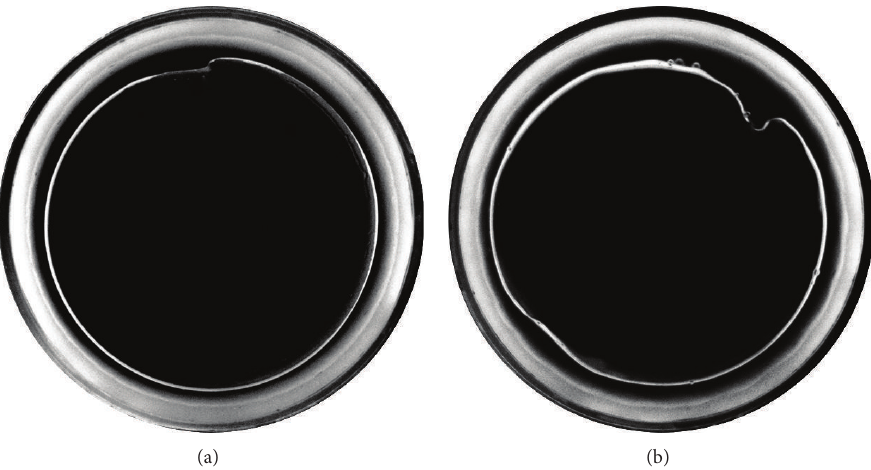
Figure 2: The azimuth inertial waves (front view): 𝑙 = 1 , 𝑞 = 0.236 , and Ω = 32.0 s −1 (a) and 𝑙 = 2 , 𝑞 = 0.247 , and Ω = 31.4 s −1 (b); ] = 3.2 cSt and 𝑚 = 250 g, hereinafter cylinder rotates